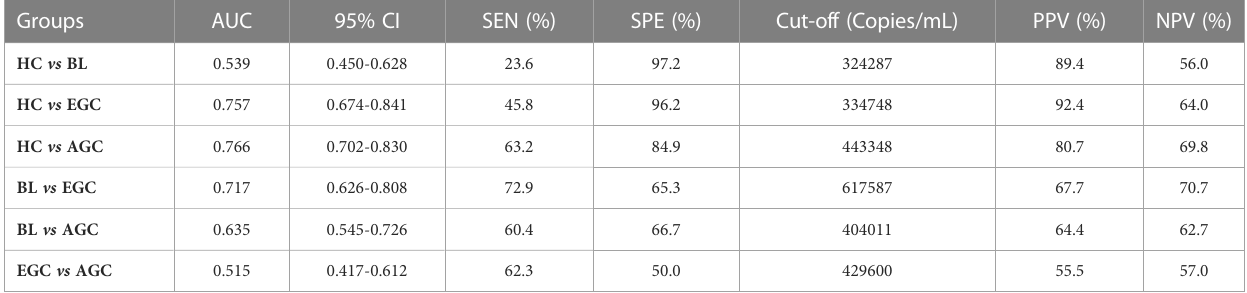
TABLE 2 The diagnostic value of tRF-33-P4R8YP9LON4VDP in monitoring gastric mucosa of different pathological states.